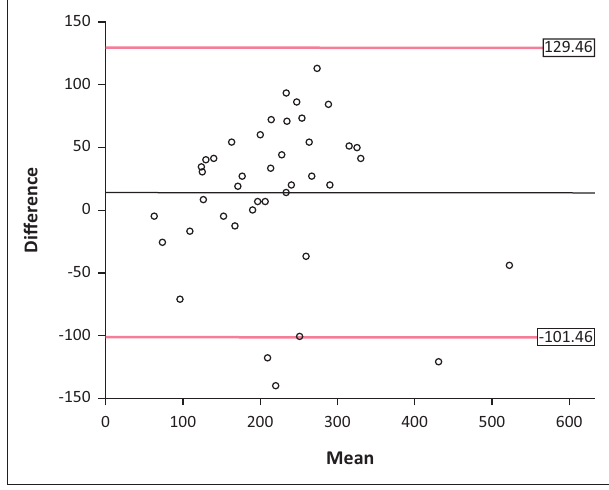
FIG URE 4: Correlation between forced vital capacity and peak expiratory flow (Pearson’s R = 0.79; r 2 = 0.62; p < 0.0001); n = 41. TABLE 2: Odds ratios for cut-off levels of peak expiratory flow and forced vital capacity and corresponding peak expiratory cough flow thresholds. Variable Odds ratio 95 % confidence interval p